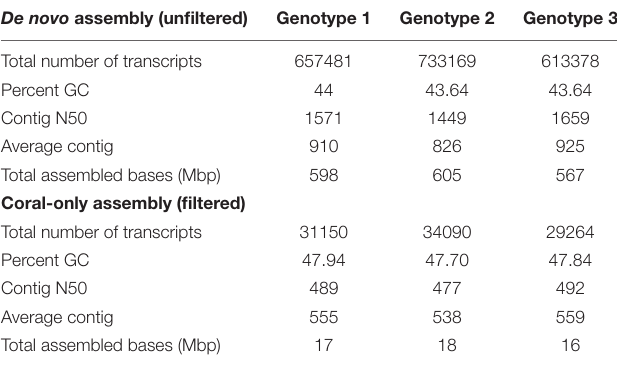
TABLE 4 | Summary statistics of de novo